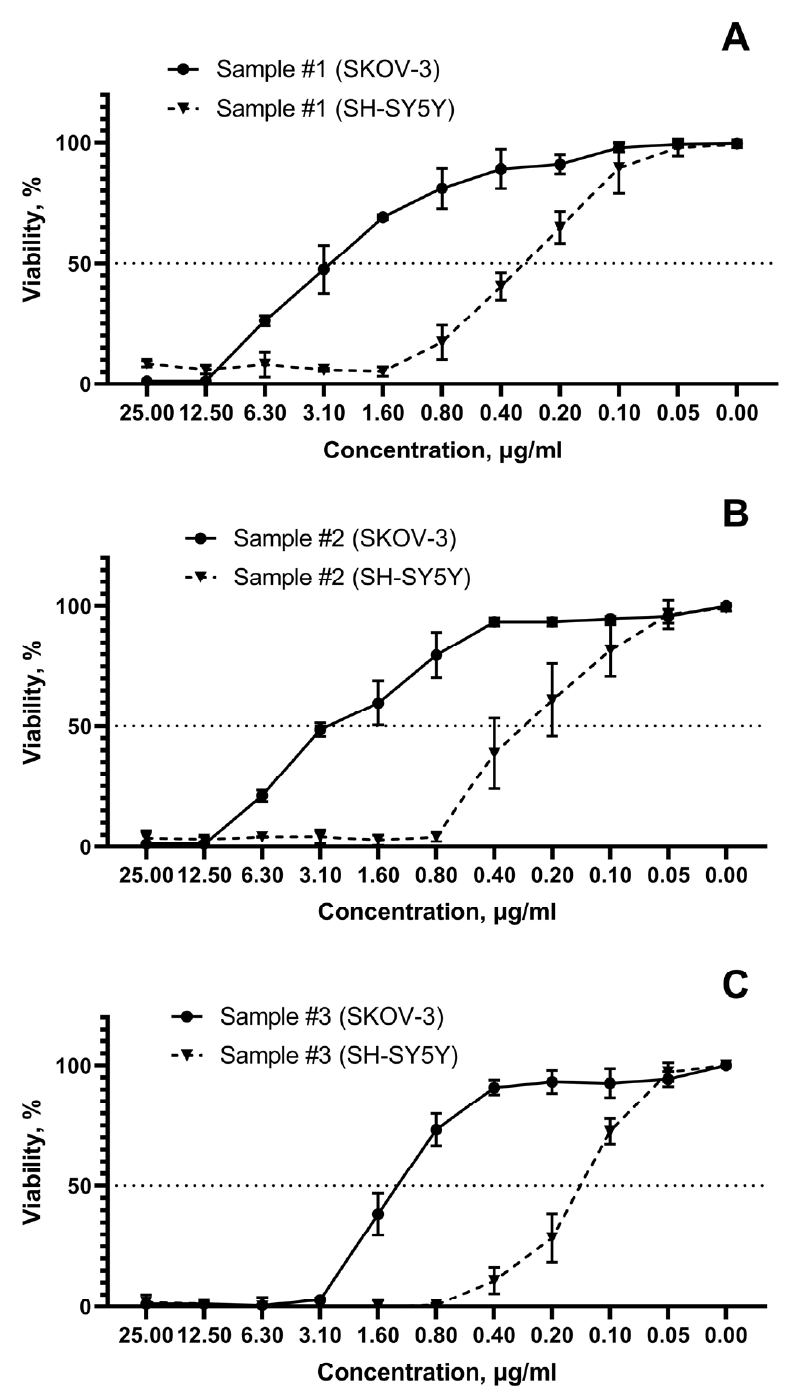
Figure 6. Cell viability depending on AgNPs concentration for the most susceptible (SH-SY5Y, neuroblastoma) and resistant (SKOV-3, ovarian cancer) tumor cell lines. ( A )—sample #1; ( B )—sample #2; ( C )—sample #3.